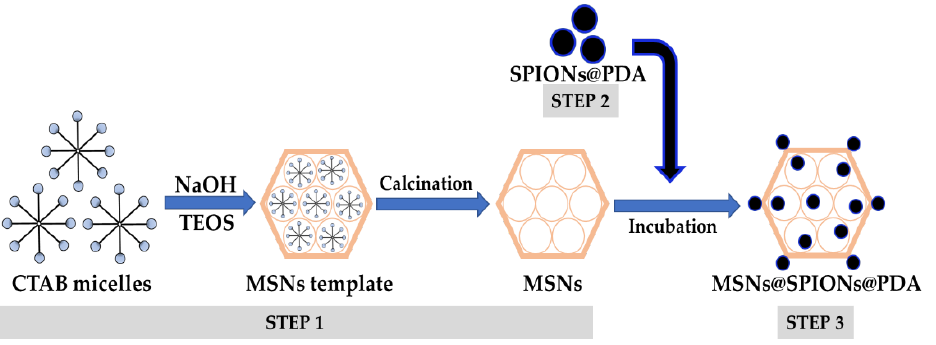
Figure 1. Schematic illustration of the synthesized MSNs@SPIONs@PDA obtained through their corresponding step method. corresponding step